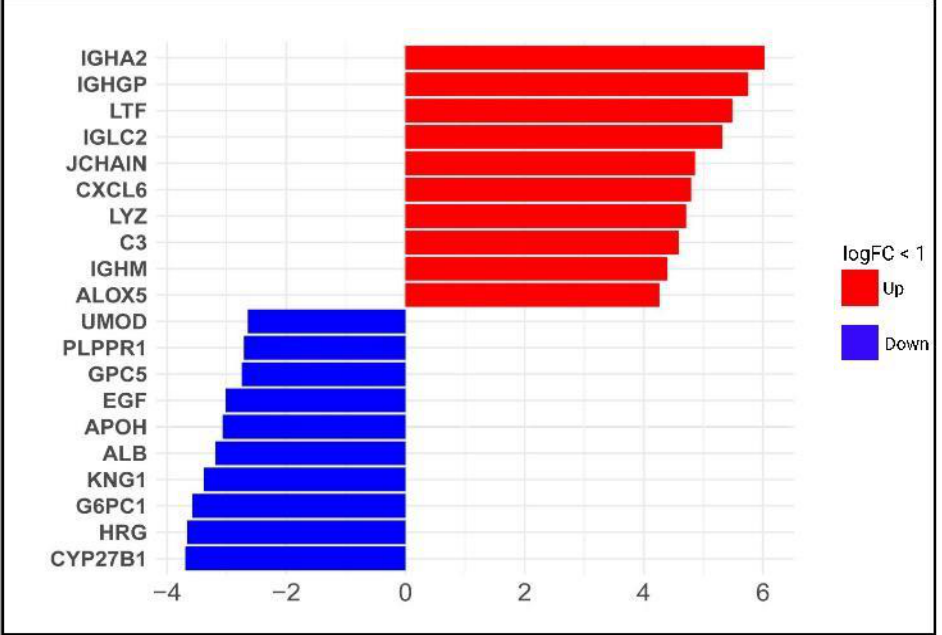
Figure 3. Top upregulated and downregulated DEGs in diabetic kidney disease dataset. Bars show the top upregulated (red) and downregulated (blue) genes, according to Log2FC values. Opposite, the top ten downregulated DEGs listed are the following. CYP27B1 (Log2FC = − 3.693, FDR = 1.24 × 10 − 6 ) encodes a protein member of the cytochrome P450 super-family of enzymes and is related to the steroid metabolism pathways. Followed by HRG (Log2FC = − 3.661, FDR = 1.09 × 10 − 8 ), a gene encoding a histidine-rich glycoprotein